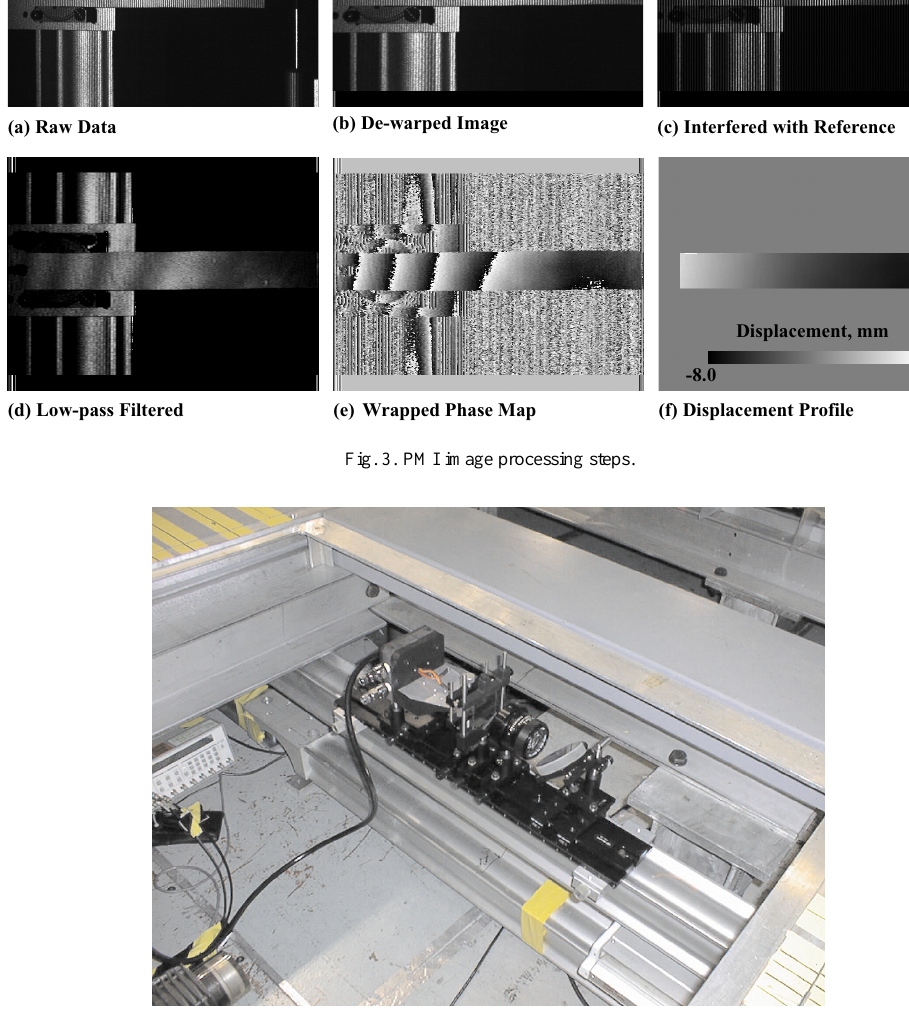
Fig. 4. PMI projection system for rotorcraft blade deformation